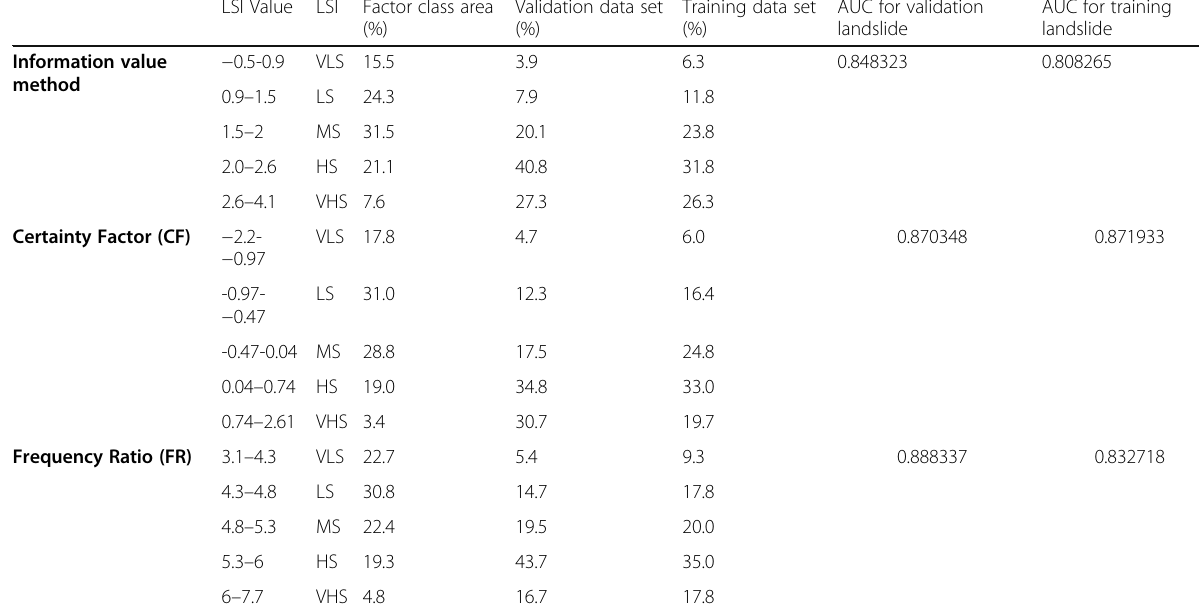
Table 3 Statistical results of landslide susceptibility map produced by frequency ration, information value, and certainty factor